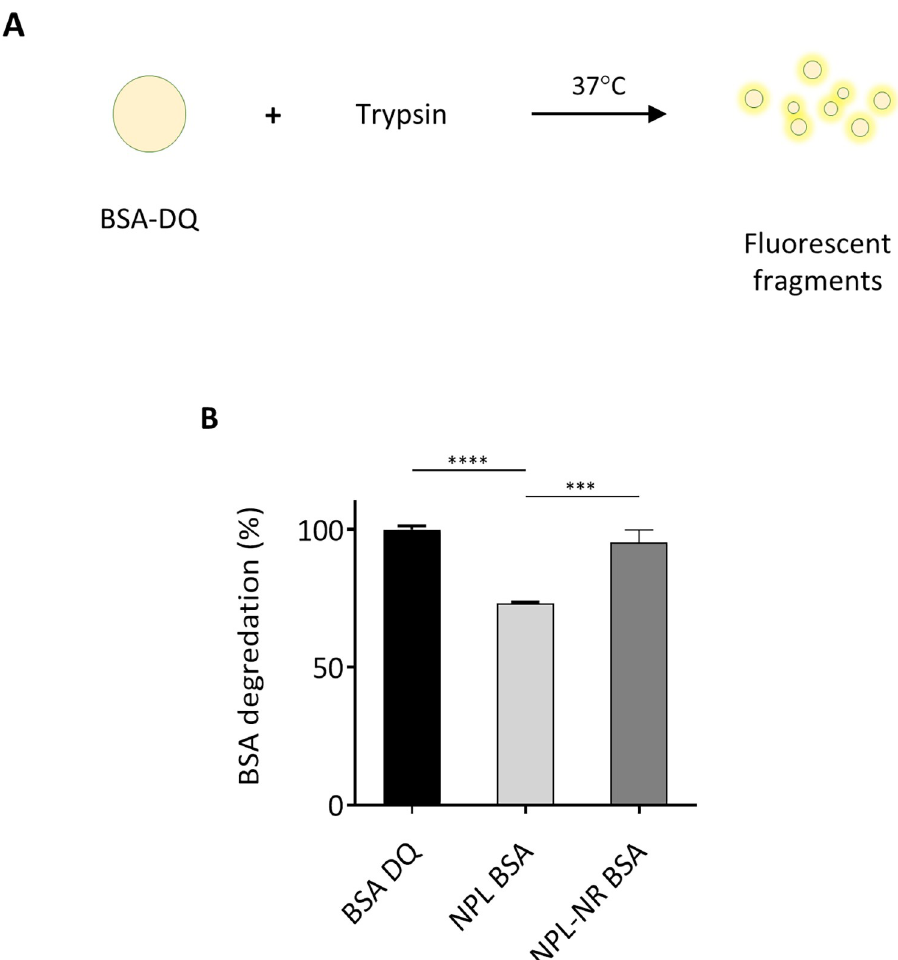
Fig 3. BSA-DQ alone or loaded in NPs was incubated in the presence of trypsin, for 2 h at 37˚C and pH 7.2 (A). The proteolysis was measured by fluorometry (B). The results represent the normalized mean ± SEM of 3 independent experiments, and statistical comparisons were made by one-way ANOVA. � p < 0.05, �� p < 0.01, ���� p <